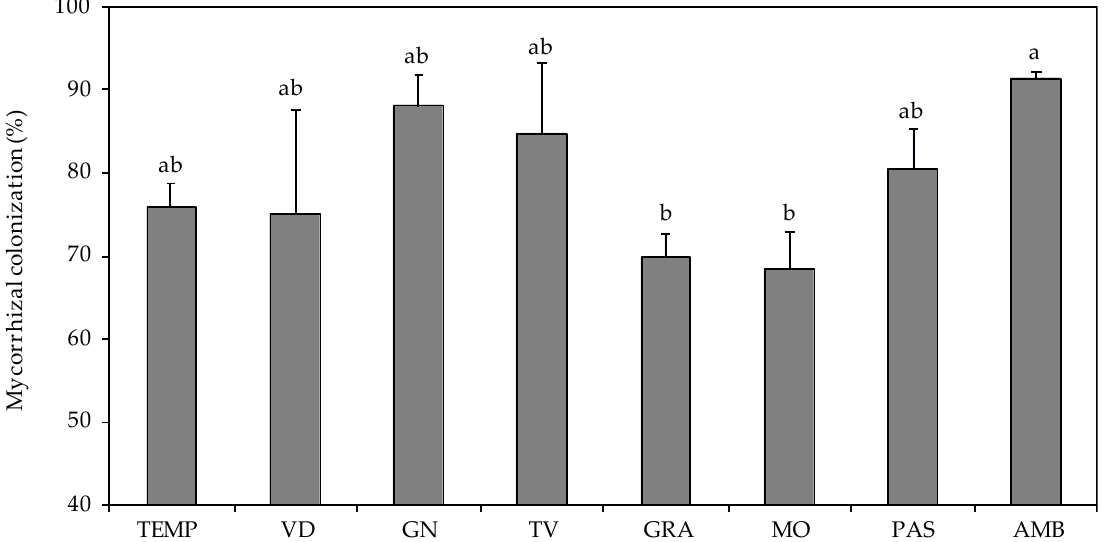
Figure 1. Percentage of mycorrhizal colonization of roots from fruit-bearing cuttings of ancient grapevine varieties. Values are means ± S.E. (n = 3). Bars topped by the same letter do not differ significantly ( p > 0.05) according to Duncan’s test. The variety labels can be found in Table 1.